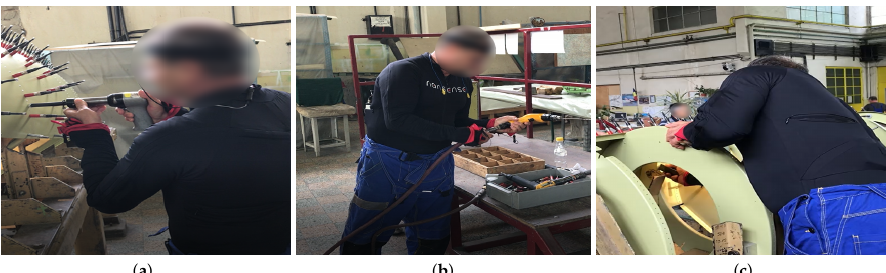
Figure 3. Gesture vocabulary with gestures for airplane assembly (G 2 ). ( a ) G 2,1 : Rivet with the pneu- matic hammer; ( b ) G 2,2 : Prepare the pneumatic hammer and grab rivets; ( c ) G 2,3 : Place the bucking bar to counteract the incoming rivet.